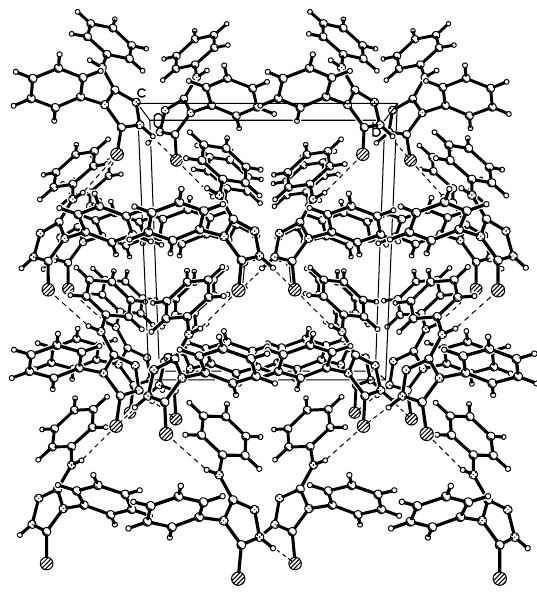
Figure 2 . A view of the crystal packing down the c axis for the title compound.